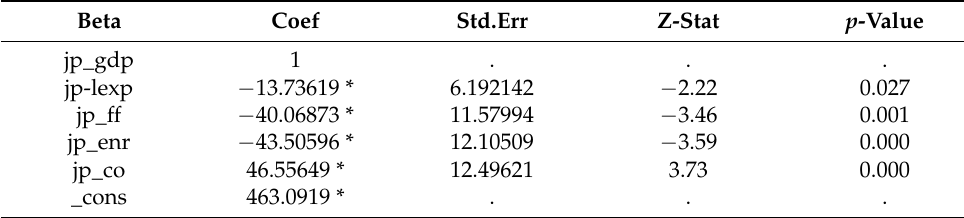
Table 15. Johansen normalization restriction imposed for Japan. Beta Coef Std.Err